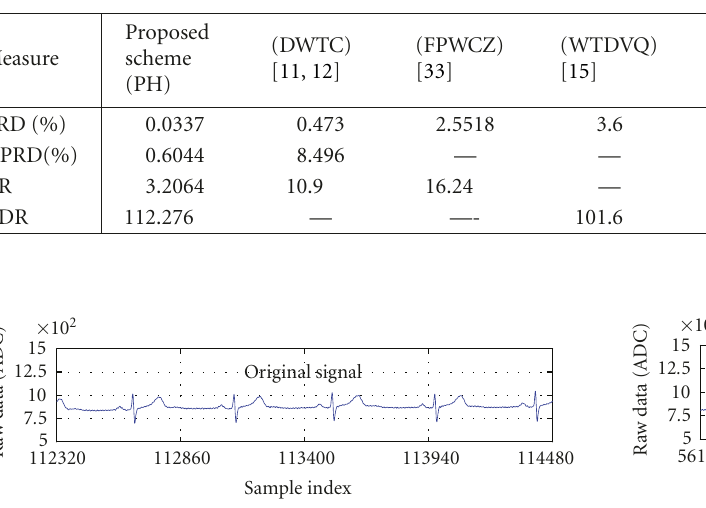
Table 9: Record MIT-ADB 117: performance comparison results with di ff erent ECG compression methods. DWTC denotes discrete wavelet